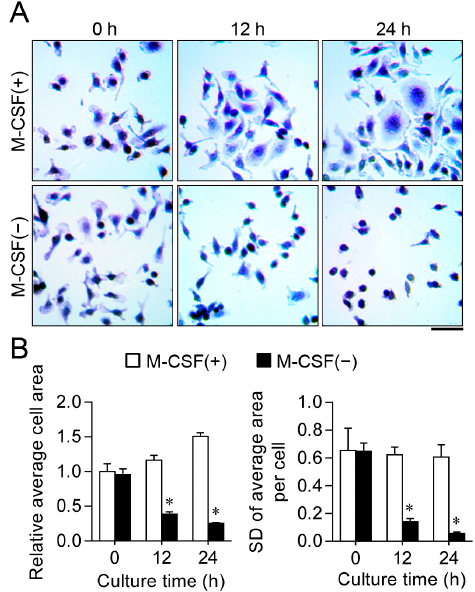
Figure 1. Effects of macrophage colony-stimulating factor (M-CSF) deprivation on the morphology and size of osteoclast progenitors. ( A ) Cells were cultured in the absence or presence of M-CSF for the indicated times and then stained with crystal violet. Scale bar: 50 µm; ( B ) Relative average cell surface area was determined by dividing the total cell area by the number of cells ( left panel ), and SD of the average area per cell was determined by measuring the area of individual cells ( right panel ), in photographs similar to those in ( A ). * Differences compared with control were statistically significant ( p < 0.01, ANOVA).